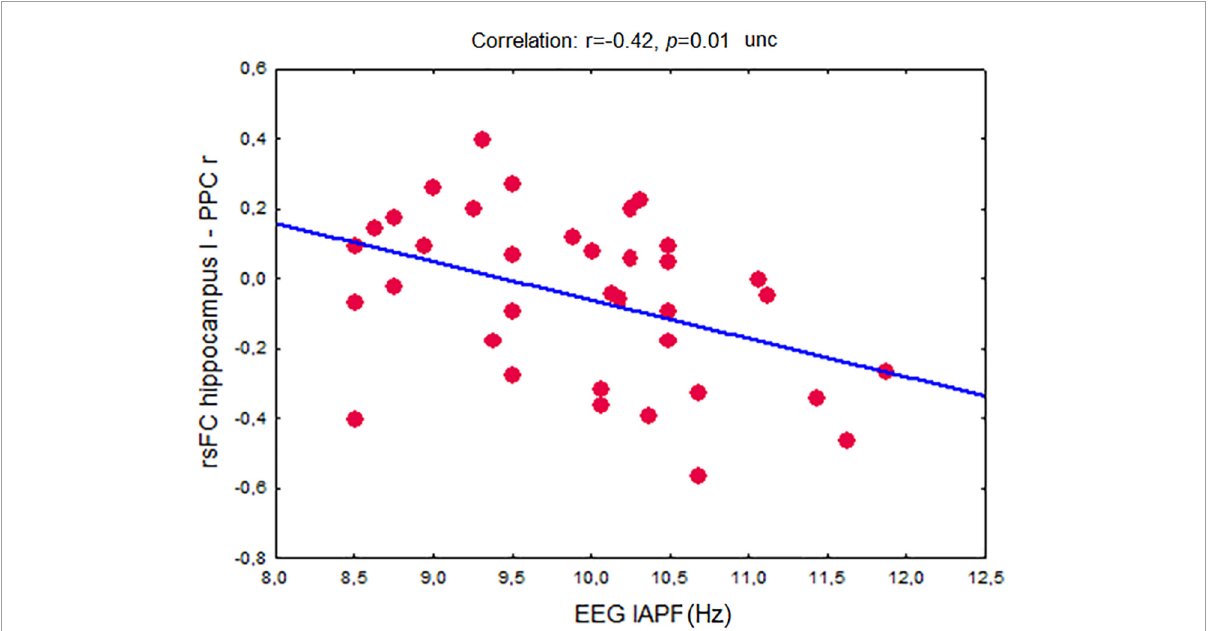
FIGURE6 Association between fMRI-derived resting-state functional connectivity in the network between the left hippocampus and the right posterior parietal cortex and EEG individual alpha peak frequency in non-demented adults. Abbreviations are the same as in Figure 1